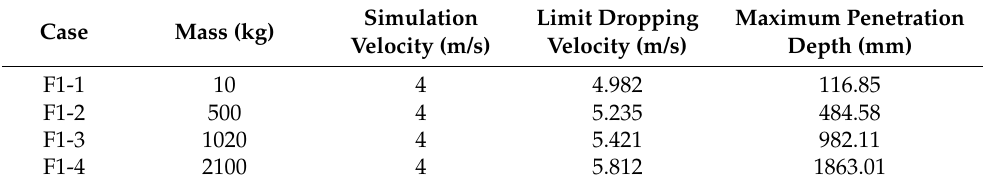
Table 6. The maximum penetration depths of different anchor weights.